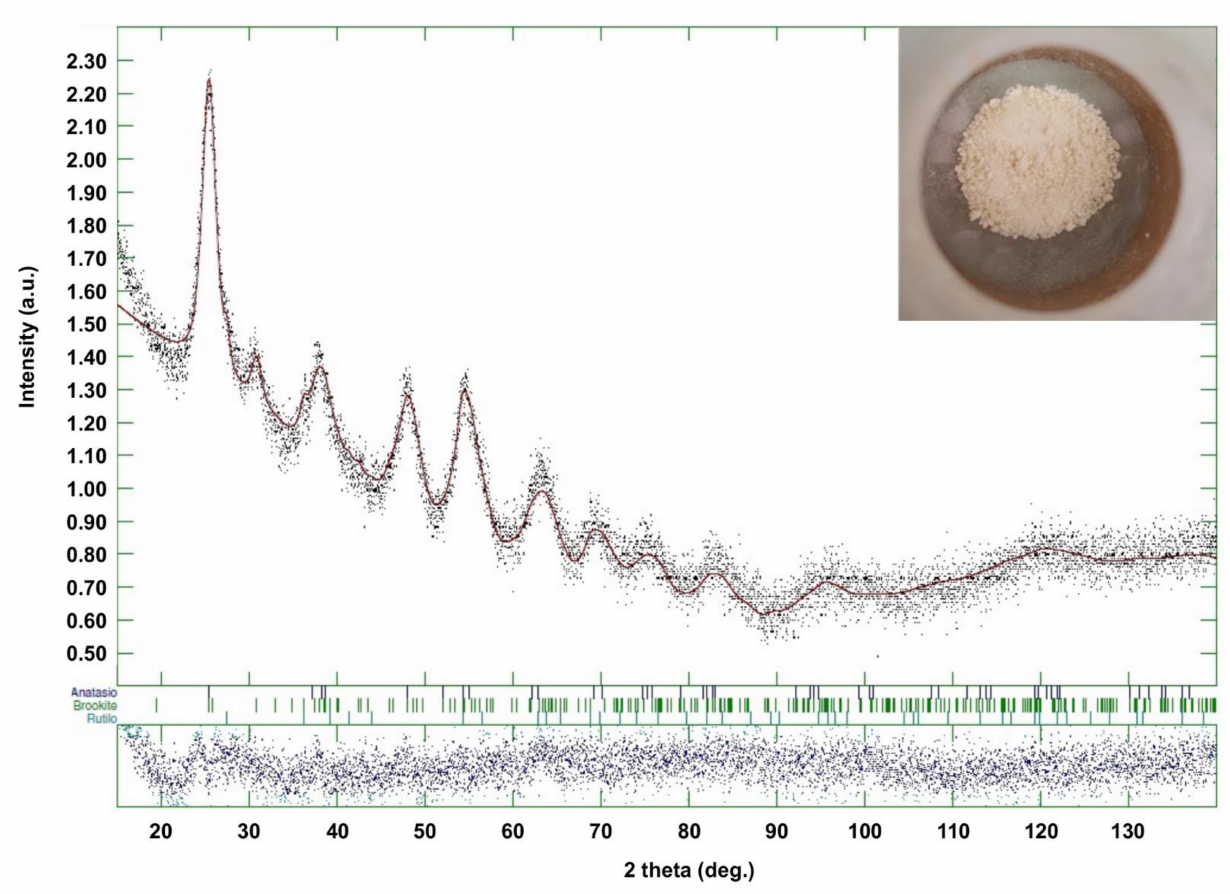
Figure 4. XRD spectrum of TiO 2 _60_Powd batch. The inset shows a photograph of the